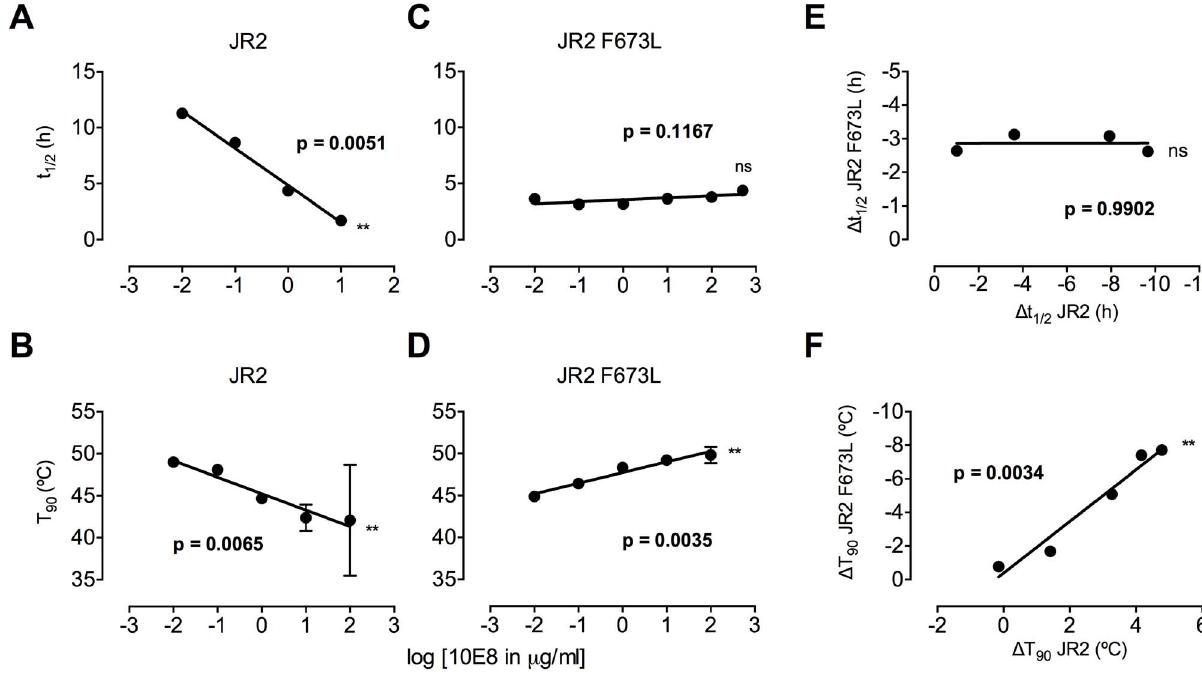
Figure 8. Enhancement by 10E8 of the functional stability of MPER mutant F673L and corresponding diminution of functional stability of wild type HIV-1 Env. ( A ) Half-life (t 1/2 ) of infectivity decay at 37 u C and ( B ) thermostability of JR2 wild type and ( C and D, respectively ) F673L mutant in the presence of incremental concentrations of 10E8. Thermostability was determined using a heat gradient to obtain the temperature at which viral infectivity drops by 90% (T 90 ). ( E ) Relationship of 10E8-induced changes in infectivity decay ( D t 1/2 ) of JR2 F673L mutant is plotted against that of wild type JR2. ( F ) The 10E8-induced change in thermostability ( D T 90 ) of wild type JR2 is inversely correlated with that of the F673L